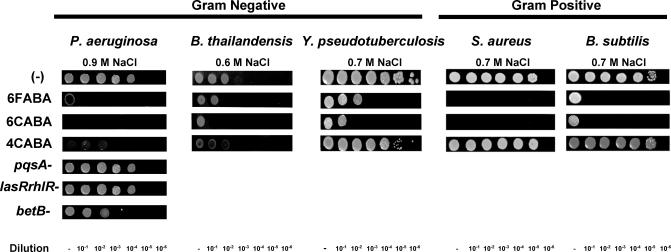
The AA Analogs Increase the Osmotic Sensitivity of Several Bacterial PathogensTen times (10×) serial dilutions of the indicated bacterial pathogens were spotted onto high-salt tester plates containing no AA analog, 6 mM 6FABA, 6 mM 6CABA, or 1.5 mM 4CABA. Note that at these concentrations, bacterial growth on regular low-salt LB plates was unaffected.